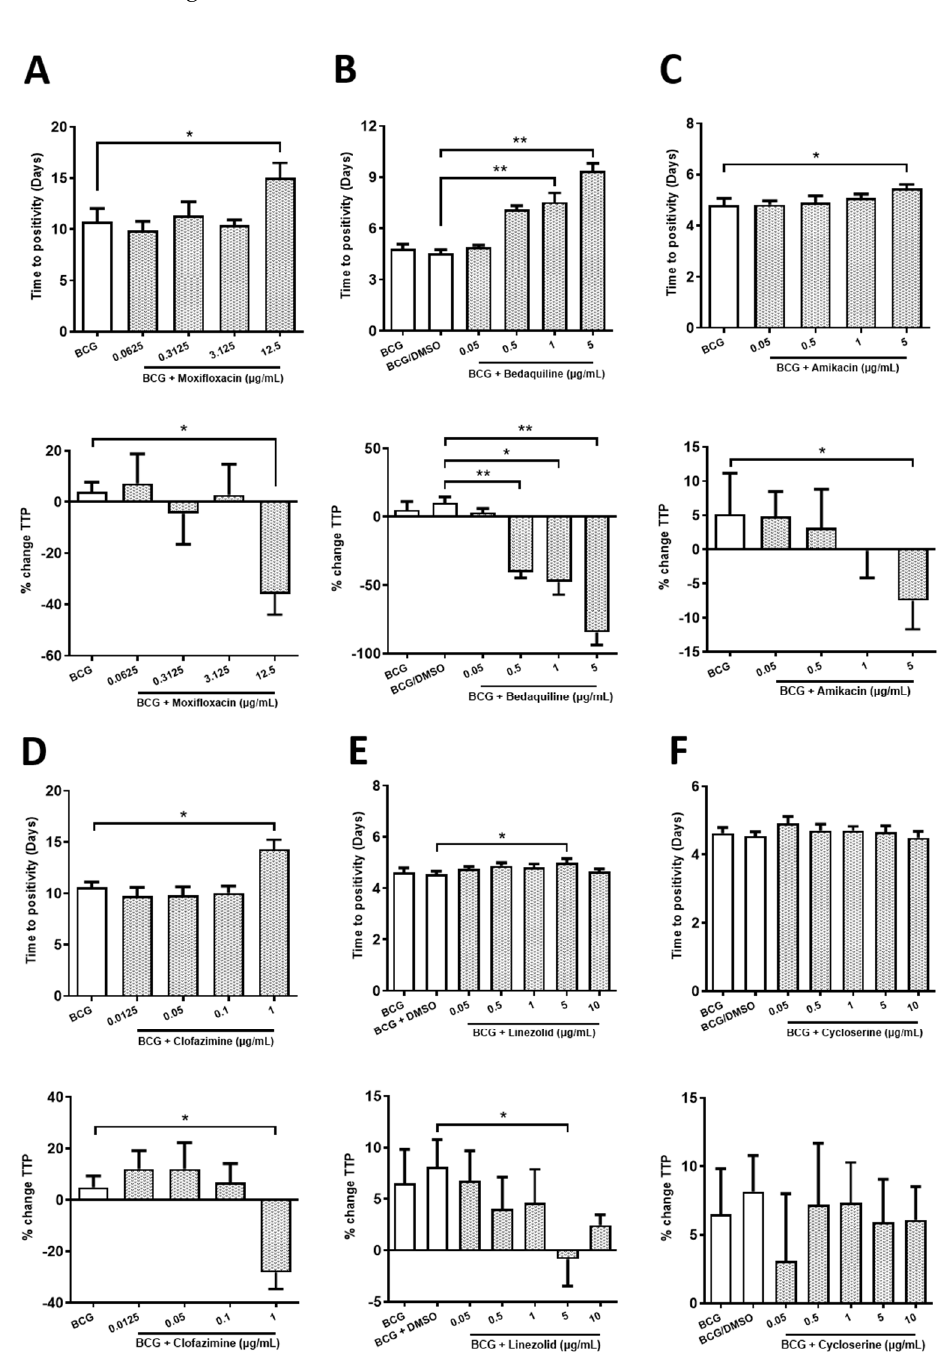
Figure 1. Determining the optimal concentration of moxifloxacin, bedaquiline, amikacin, clofazimine, linezolid and cycloserine in hMDMs infected with BCG. hMDMs, obtained from healthy blood donors, were infected with BCG for three hours and were subsequently treated with ( A ) moxifloxacin (0.0625, 0.3125, 3.125 and 12.5 µ g/mL; n = 6), ( B ) bedaquiline (0.05, 0.5, 1 and 5 µ g/mL; n = 3–4), ( C ) amikacin (0.05, 0.5, 1 or 5 µ g/mL; n = 3–4), ( D ) clofazimine (0.0125, 0.05, 0.1 and 1 µ g/mL; n = 4–5), ( E ) linezolid (0.05, 0.5, 1, 5 and 10 µ g/mL; n = 3–7) or ( F ) cycloserine (0.05, 0.5, 1, 5 and 10 µ